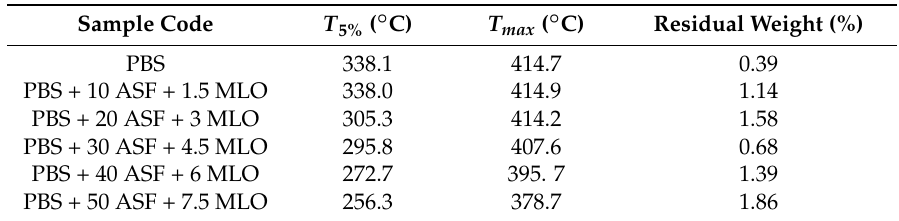
Figure 5. ( a ) thermogravimetric (TGA) degradation curves and ( b ) first derivative (DTG) of PBS/ASF/MLO composites with varying ASF loading. Table 4. Main thermal degradation parameters of PBS/ASF/MLO composites with varying ASF content, obtained by thermogravimetric analysis